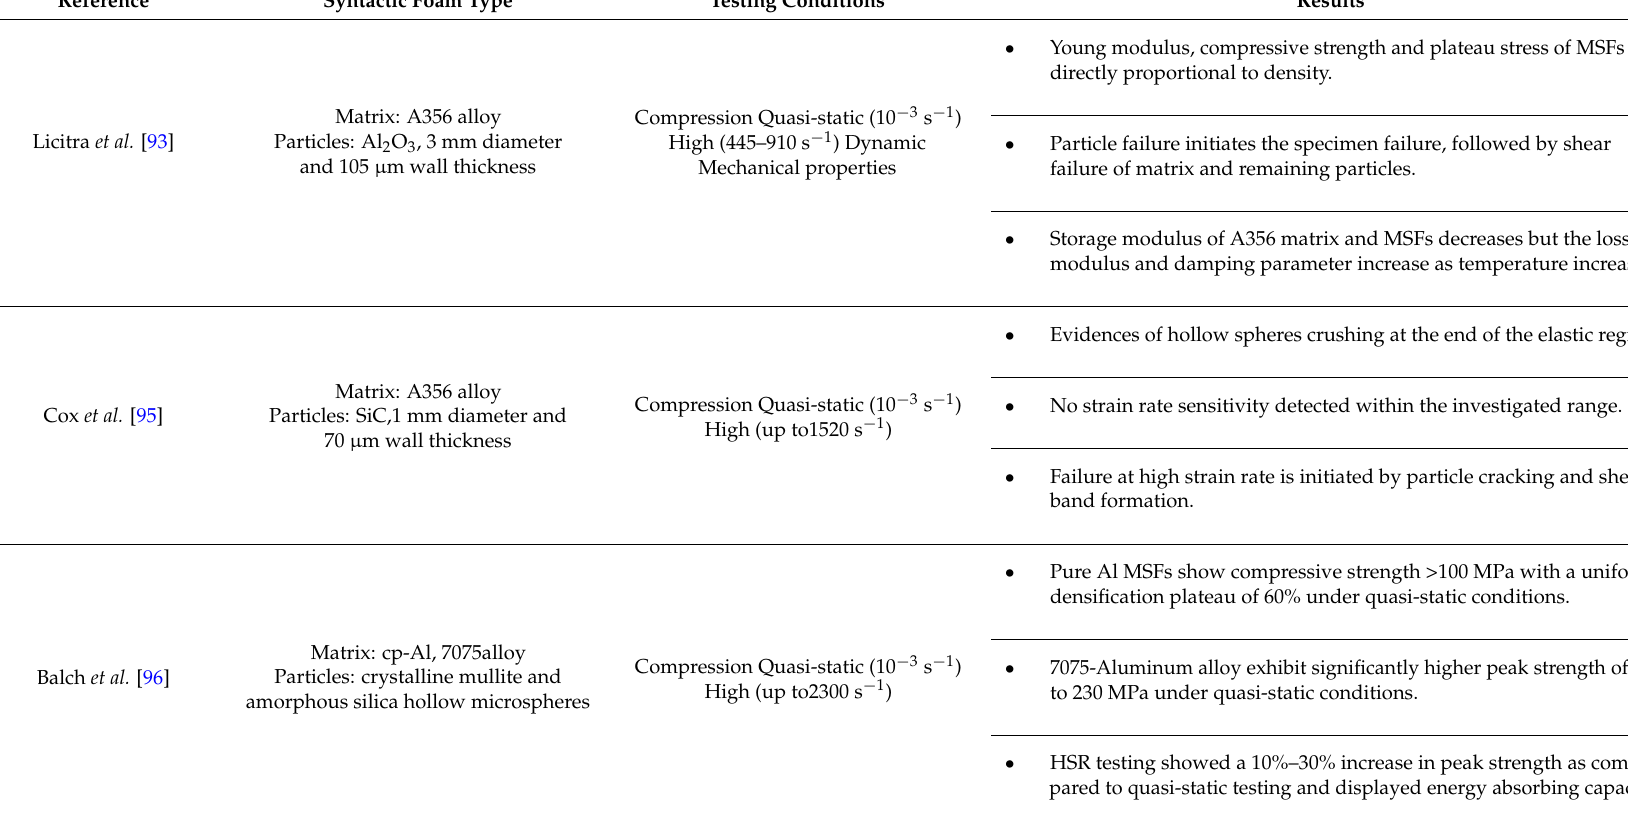
Table 4. Literature survey on aluminum alloy syntactic